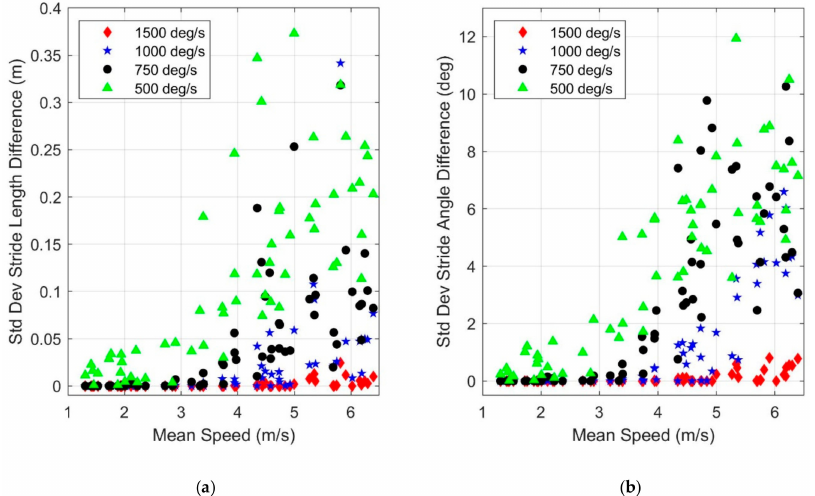
Figure 10. Dependence of the standard deviation of the di ff erence in ( a ) stride length and ( b ) stride angle estimates with mean speed and gyro range. The di ff erences are computed with respect to the results of the 2000 deg / s gyro as the